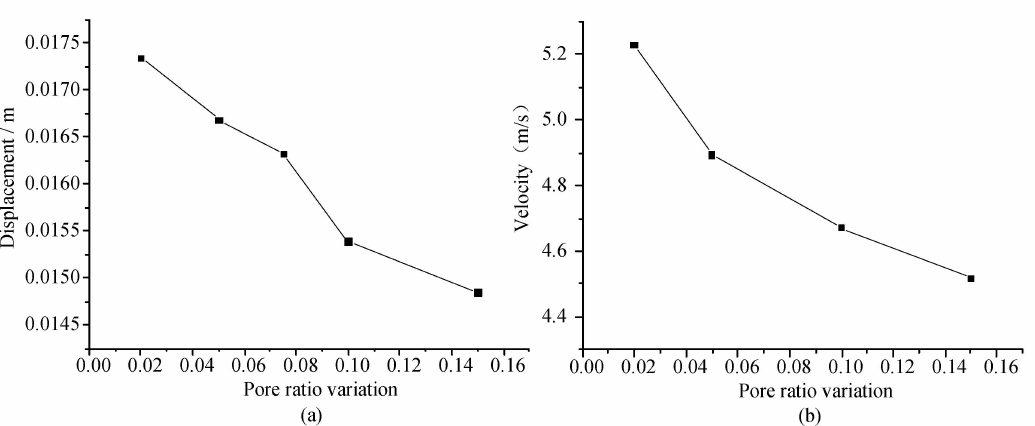
Figure 7. The maximum displacement and velocity statistics of fracture block of coal samples with different pore ratios: ( a ) maximum displacement comparison of fracture coal blocks; ( b ) maximum velocity comparison of fracture coal